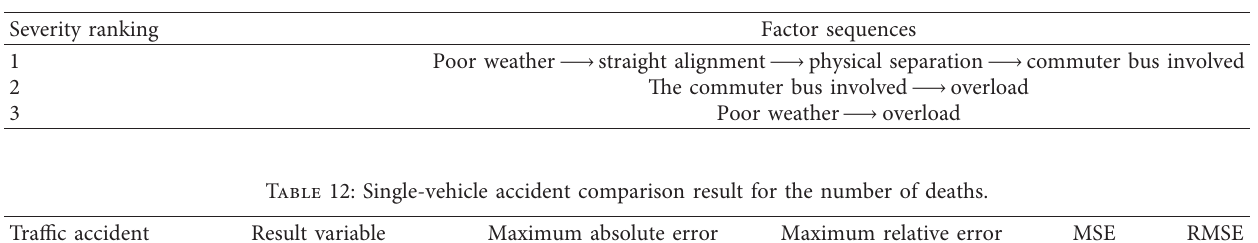
Table 11: Factor combination sequence result for the number of injuries.